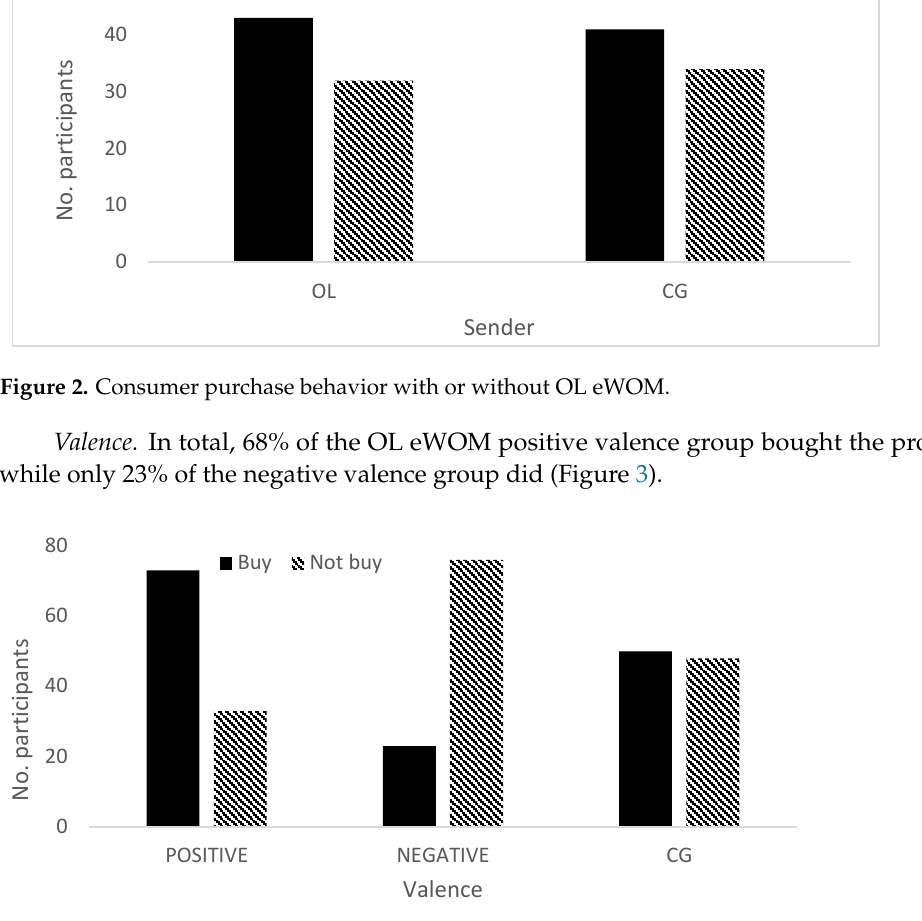
Figure 4. Consumer purchase behavior according to product type. 4.2. Regression Coefficients and Hypotheses Testing To answer the research questions, we analyzed the data collected at the online store using SPSS Version 22. To test the three hypotheses, a Factor Analysis of Variance (FAN- OVA) with a Mixed Effect was conducted (Table 4) to assess the relationship between the dependent variable (purchase/no purchase (ST)) and the independent variables (OL eWOM and valence (positive/negative)) and product type (search/experiential goods). This analysis was the most appropriate due to the presence of non-normal data [51]. Pre- liminary tests performed on our sample showed the presence of non-normal data, partic- ularly variable time. Therefore, FANOVA with a Mixed Effect, which is less severe when used for this type of bias, was conducted [52]. Table 4. Factor Analysis of Variance (FANOVA) for Mixed Effect and Hypotheses testing. Main Effect and Interactions